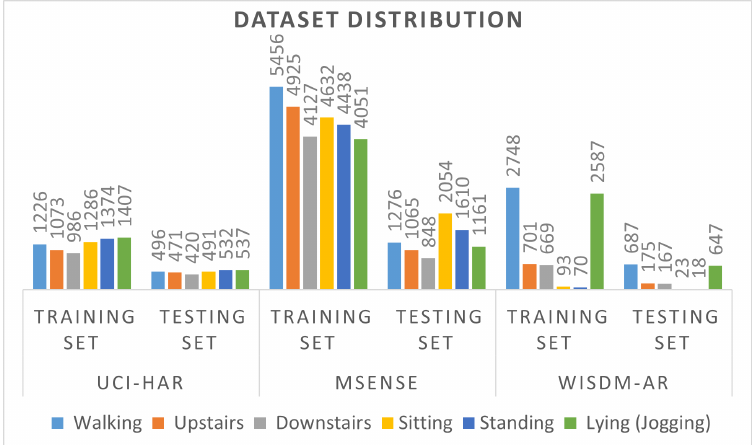
Figure 5. Training and testing set distribution of the selected